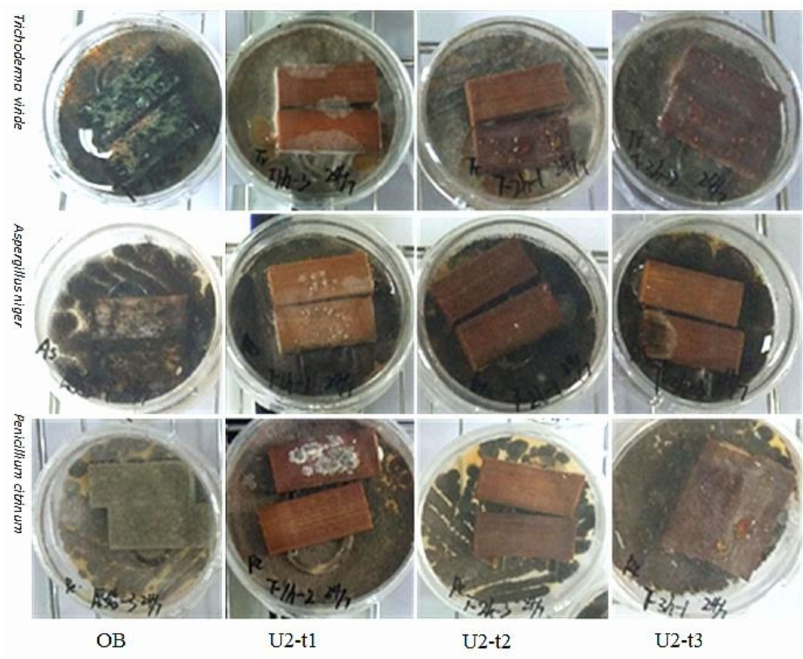
Figure 6. The mildew-proof e ff ect after 28 days of bamboo